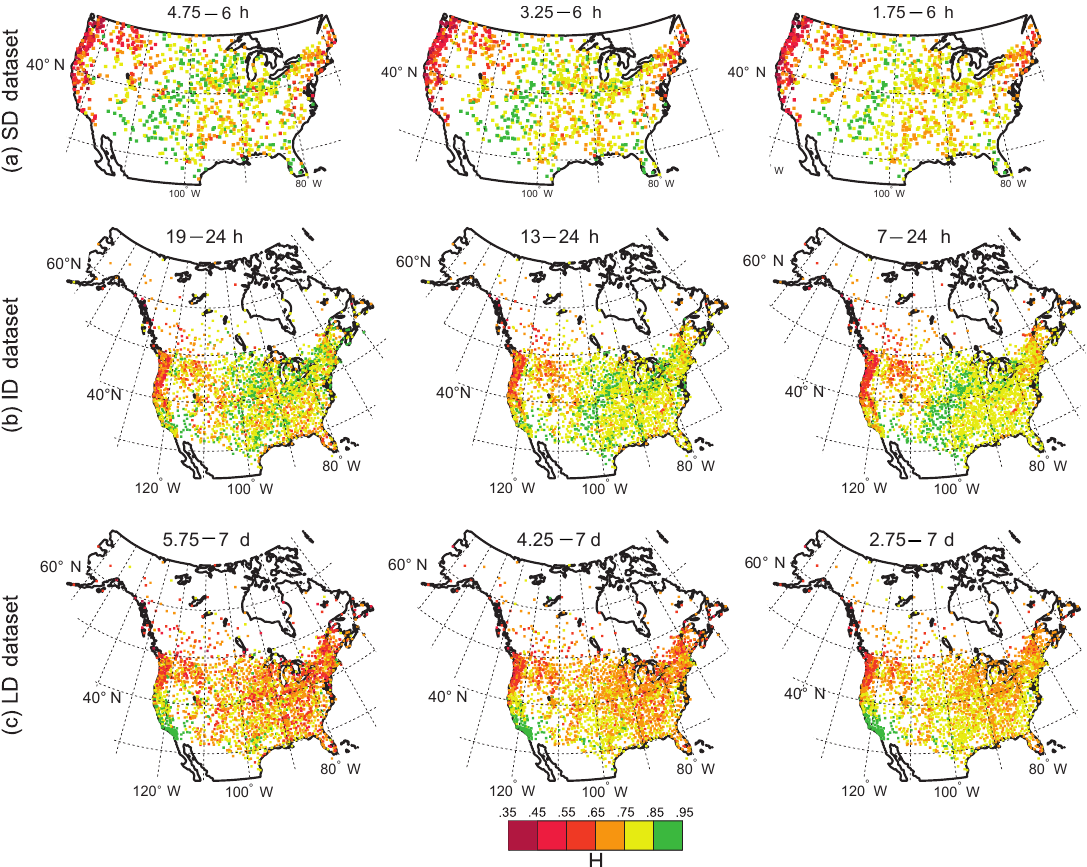
Figure 6. Spatial distribution of the scaling exponent for the last (i.e., with maximum d 1 ) 6-, 12-, and 18-duration scaling intervals (first, second, and third column, respectively) for SD, ID, and LD datasets (panels a , b , and c , respectively). These scaling intervals correspond to the last column of matrices in Figs. 2 and